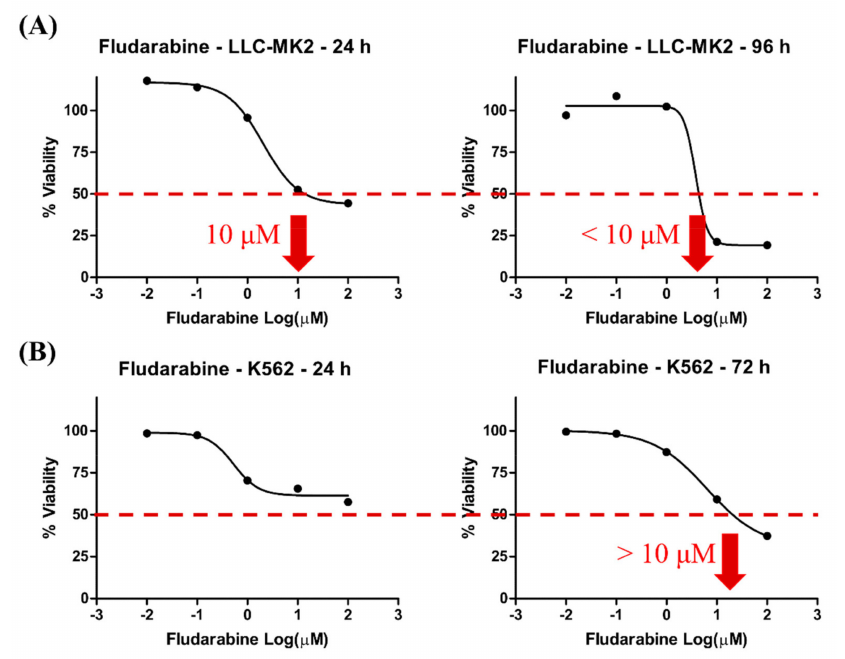
Figure 1. The time- and concentration-dependent effects of Fdb on ( A ) LLC-MK2 and ( B ) K562 cells. The cultured cells were treated with Fdb concentrations of 0, 2.5, 5, and 10 µ M. Percentage of cell viability was determined after 24, 72, and 96 h of incubation at 37 ◦ C in a 5% CO 2 incubator by MTT assay. The dotted line indicates axis intercepts of IC 50 and the log (dose) estimating